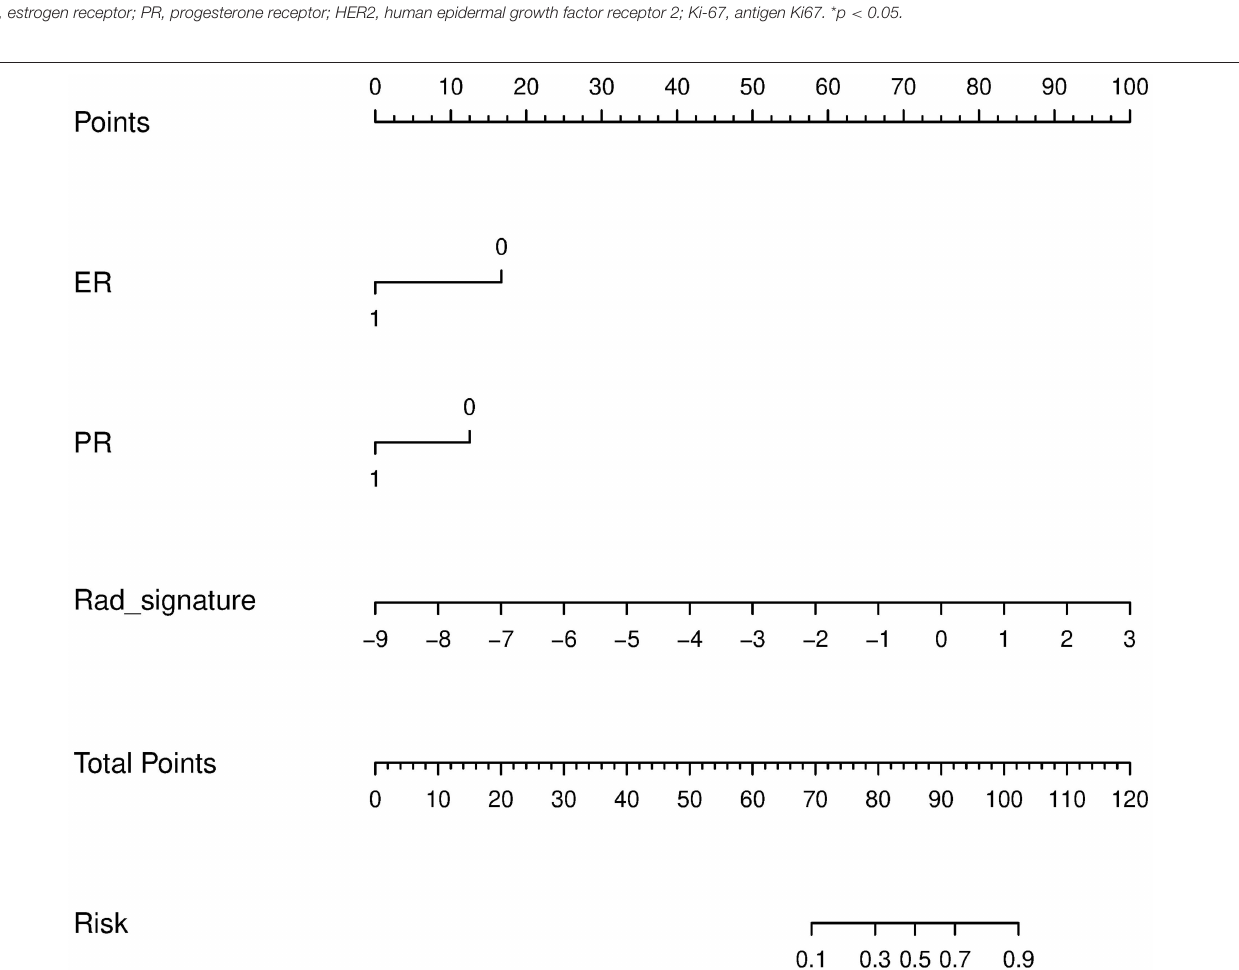
the nomogram constructed by the training set. The number of pCR cases was significantly different between the high and low probability groups ( p < 0.0001). In addition, DCA curves showed